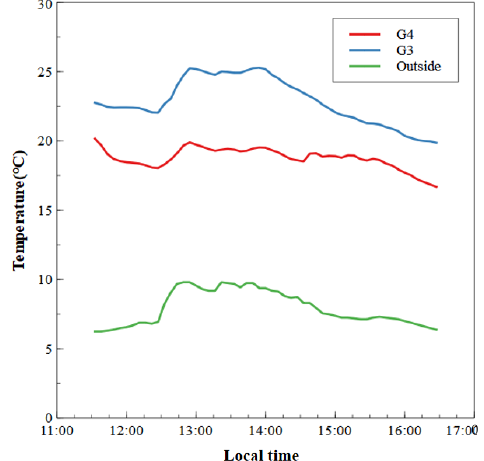
Figure 5. G3 and G4 average temperature data.